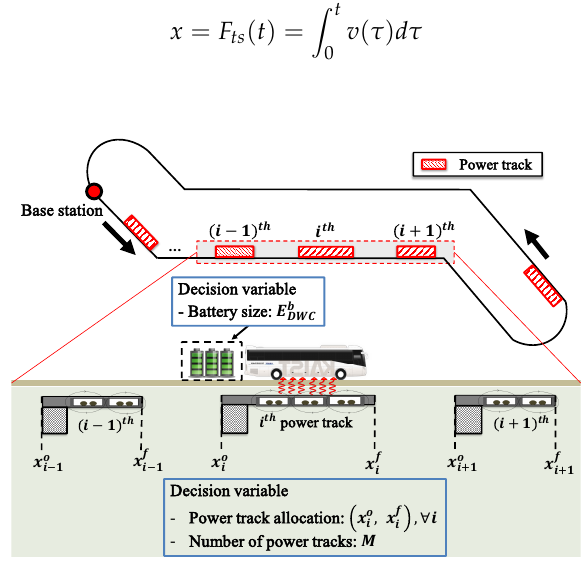
Figure 9. Decision variables for the system design of